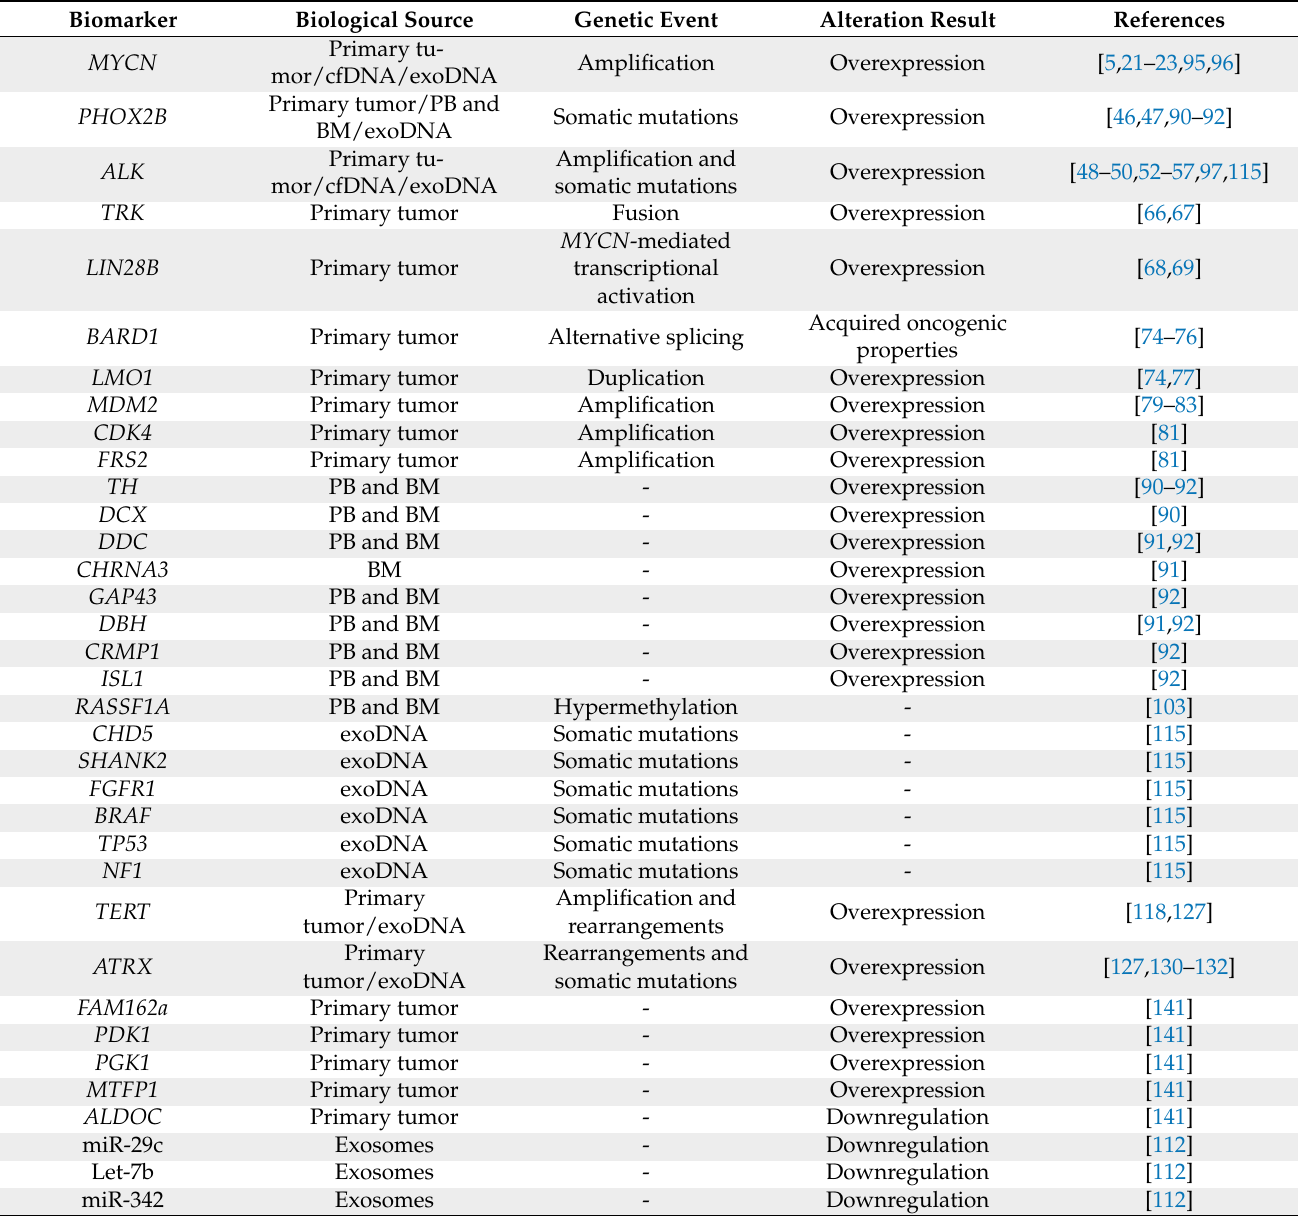
Table 1. Markers of unfavorable prognosis in